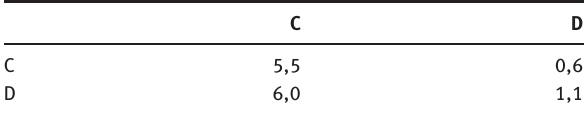
Table 1: Prisoner’s Dilemma Game That Is Used in the Experiments.